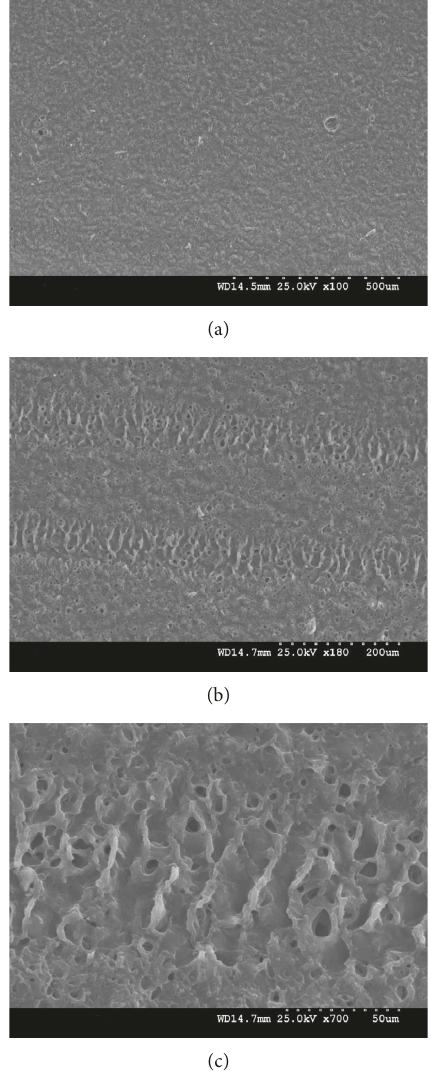
Figure 10: Surface morphology examination by scanning electron microscopy. (a) Unworn surface of PVA hydrogel. (b) Scanning electron micrograph of the wear surface, two wear tracks had formed. (c) The enlarged view of a wear track.